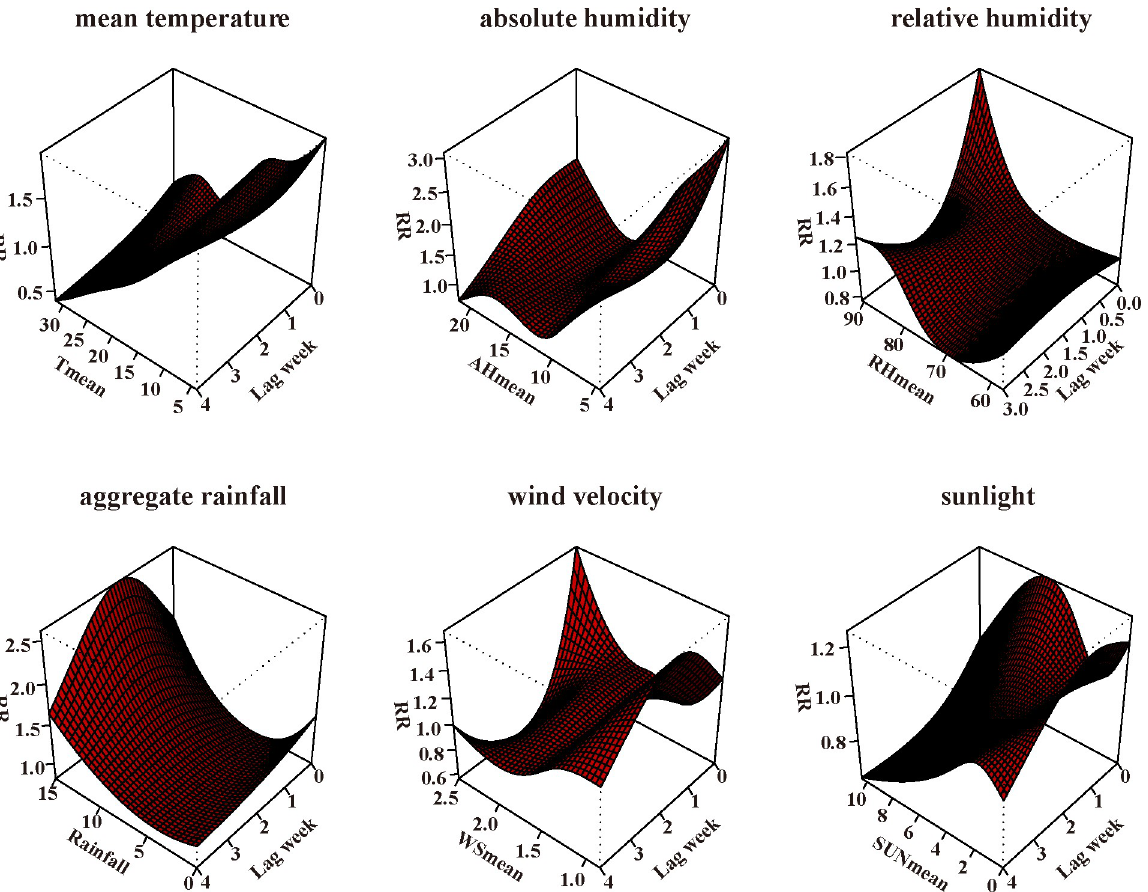
Fig 2. Plot of the relative risks of meteorological factors on influenza activity in Chongqing, China,